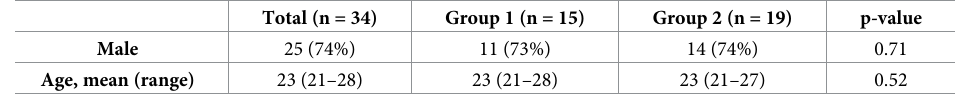
Table 1. Participant characteristics.